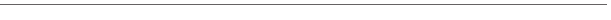
TABLE 3 | KEGG pathway analysis for differentially methylated genes. We used missMethyl tool for pathway analysis. For each enriched pathways, N is the total gene in given pathways, DN is the number of mapped genes in hg38 against differentially methylated CpGs, P.DM is the p -value, and FDR is the BH adjusted P